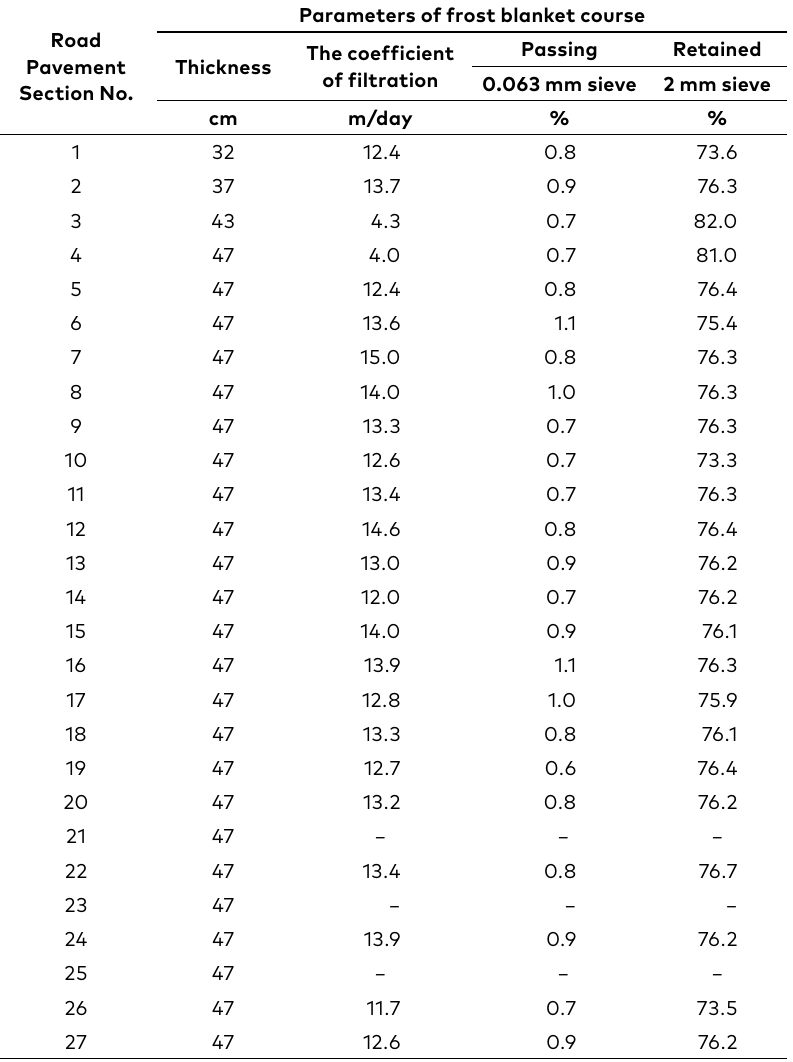
Table 2. Data of physical parameters of frost blanket